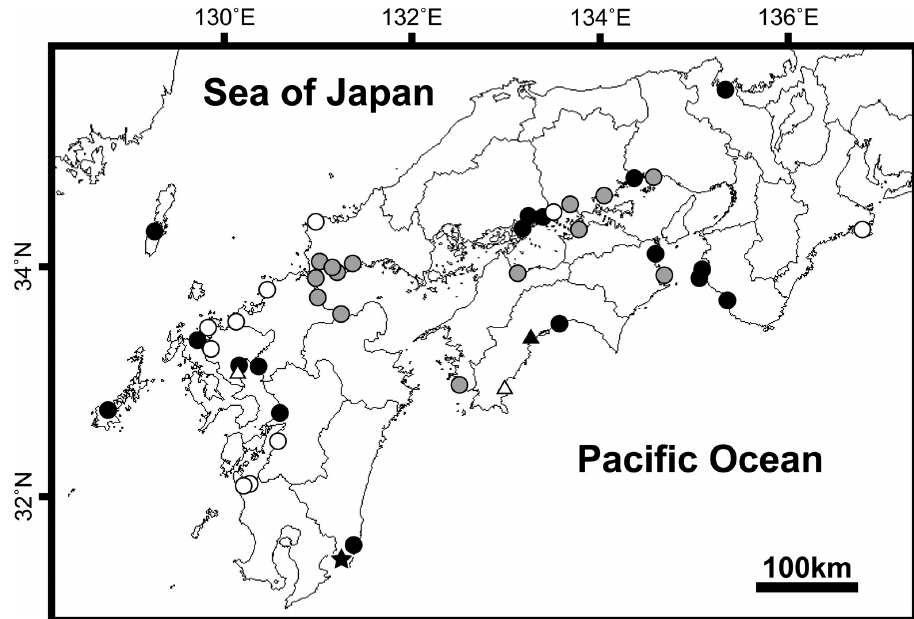
Figure 2. Distribution map of Apocryptodon punctatus in Japanese waters. Solid star indicates the present record from Kushima City, Miyazaki Prefecture, Kyushu; solid circles, records with voucher specimens deposited in a museum; gray circle, records with additional museum specimens in the present study; open circles, records with uncatalogued specimens; solid triangle, photo record; open triangles, literature records without a